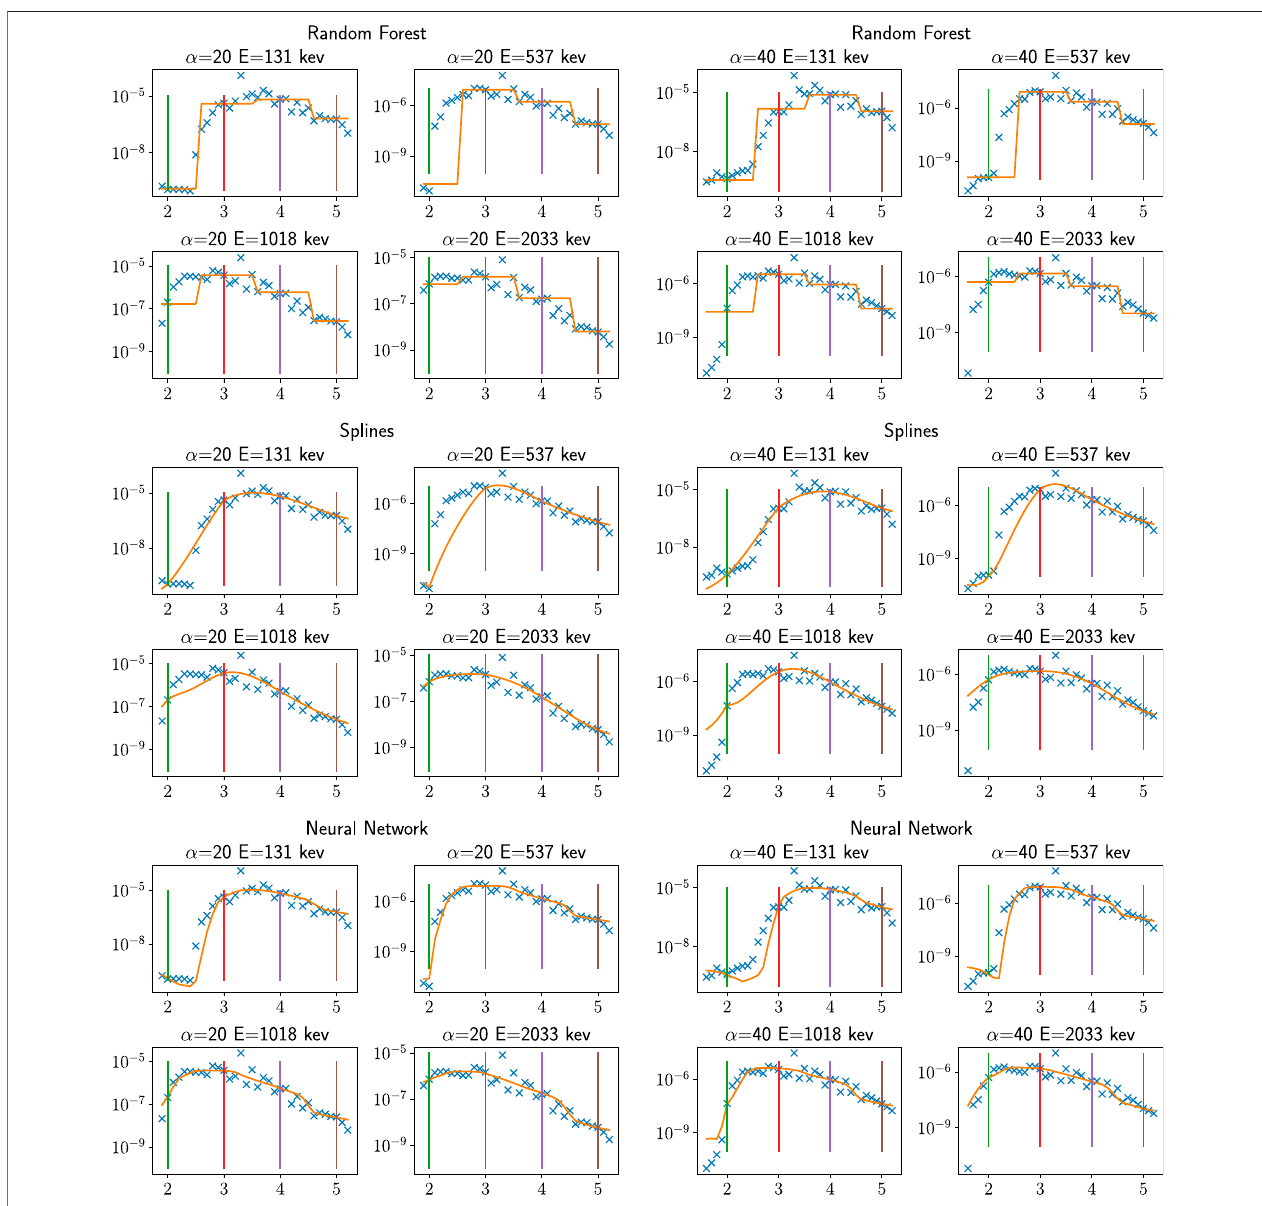
FIGURE3| Machinelearningpitchanglediffusioncoef fi cients( D αα ( L )in s − 1 onthe Y -axis)fortheMarch2013stormplottedinorangecolorversusL-shell( X -axis)for variouspitch-angles (20 ° and 40 ° ) and energies (131, 537,1,018,2,033 Kev)computed from(top) random forest,(center) thinplate spline,(bottom)neural network.The blue dots are the reference original diffusion coef fi cients (points of TEST_M13_L which were not used in the training and testing phase). Vertical lines represent the locationofthetrainingdataofTRAIN_M13( L =2,3,4,5).TheseplotsweremadewithmethodsthatweretrainedonasubsetofTRAIN_M13:weusedfewerpoints in energy and